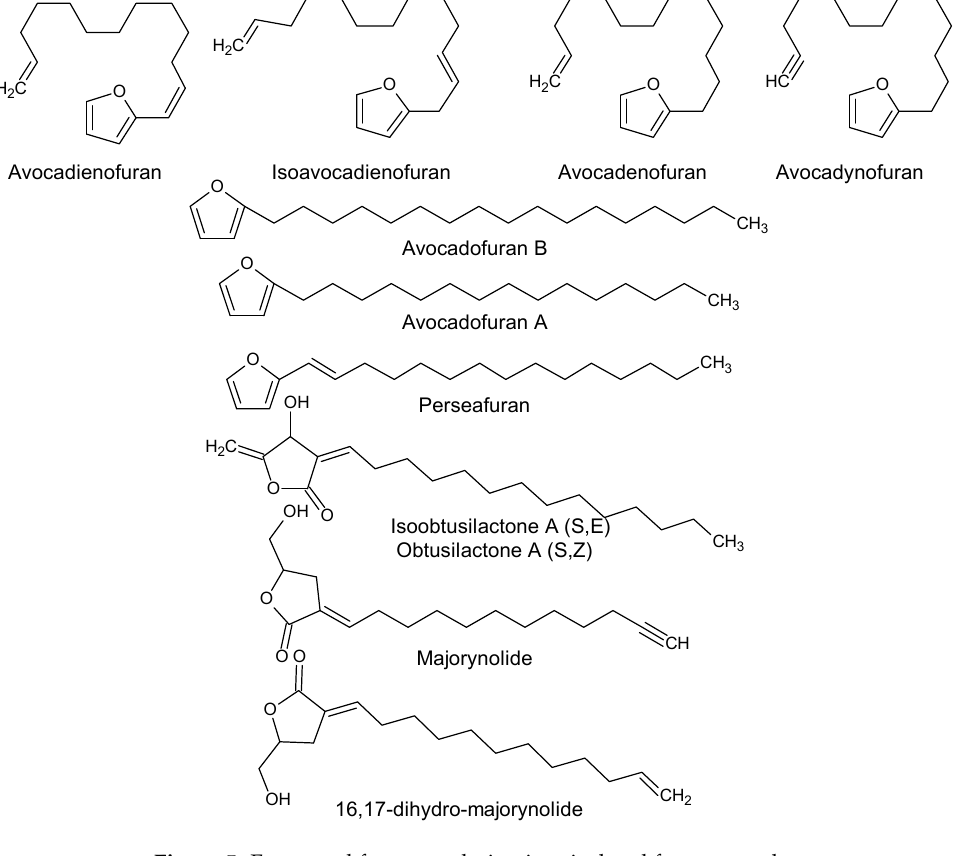
Figure 5. Furan and furanone derivatives isolated from avocado.